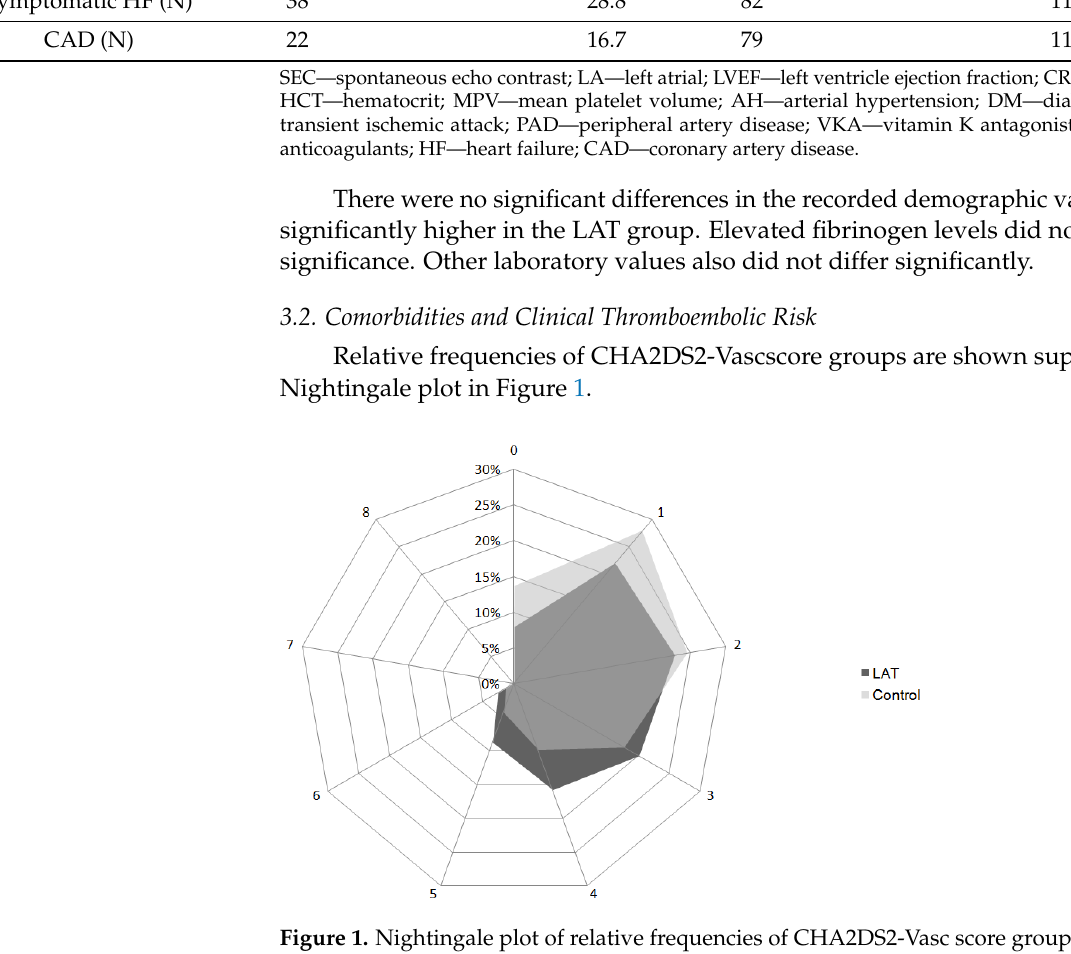
Figure 1. Nightingale plot of relative frequencies of CHA2DS2-Vasc score